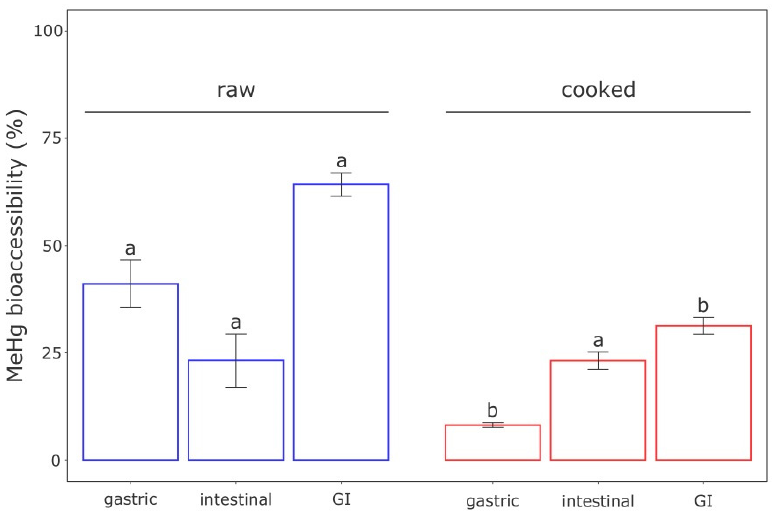
Figure 1. Methylmercury bioaccessibility (%) according to the digestive compartment assessed from raw and cooked tuna muscle ( n = 5). GI: gastric plus intestinal bioaccessibility. Letters indicate a significant difference (Wilcoxon tests, p ≤ 0.05) between treatments. Error bars present the standard deviation of the quintuplicates.